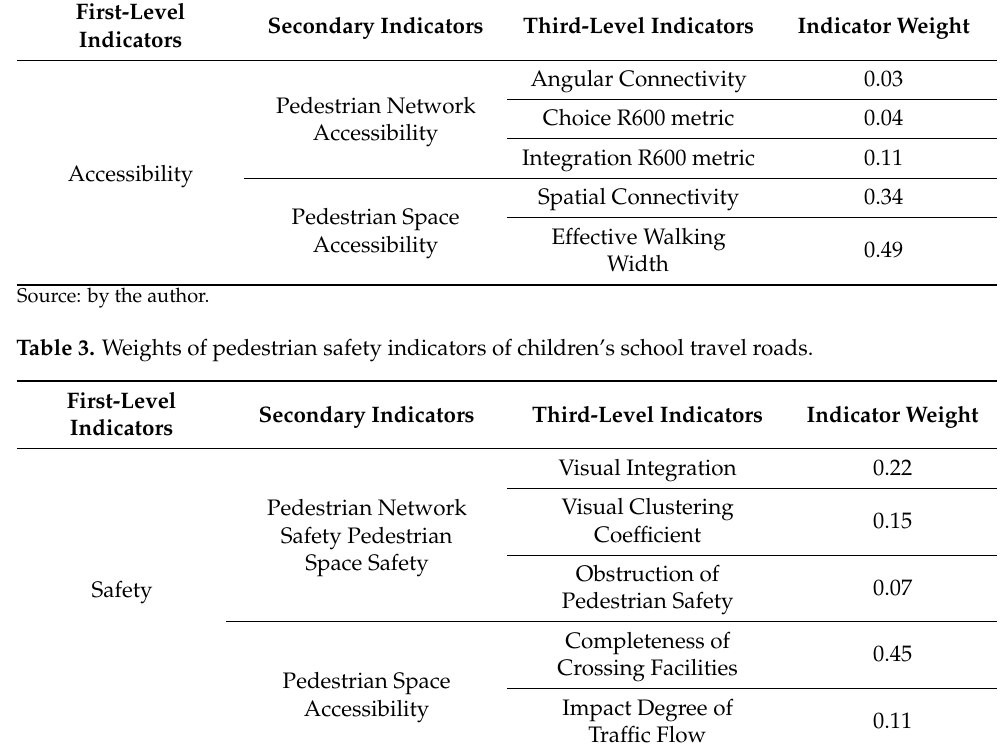
Table 3. Weights of pedestrian safety indicators of children’s school travel roads.